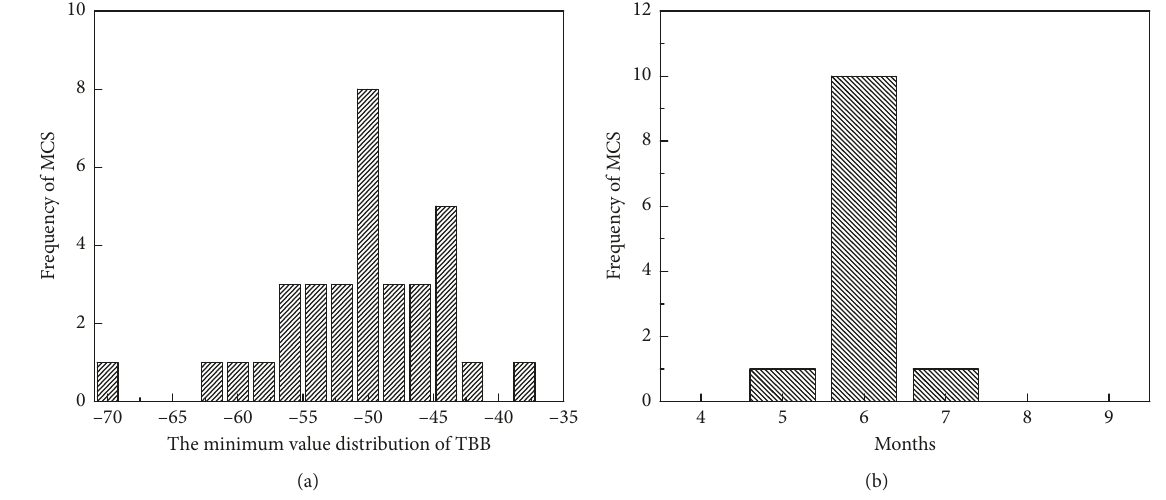
Figure 3: Distribution of (a) TBB min and (b) deep convection in each